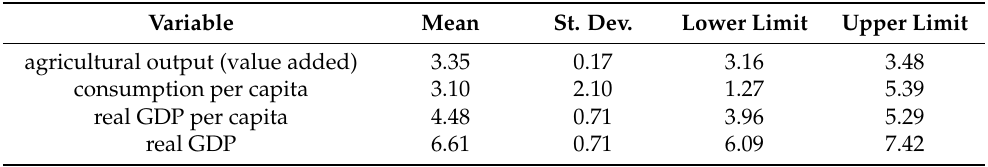
Table A1. Projected average annual growth (%) in selected variables in a baseline (no GERD) scenario over the next 3-year period based on VECM